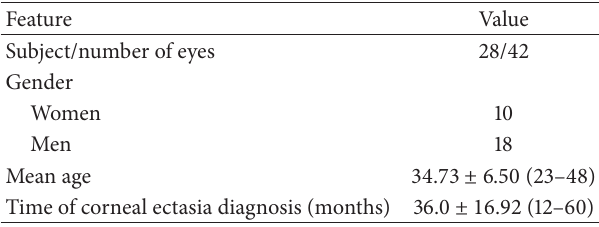
Table 1: Demographical features of subjects.